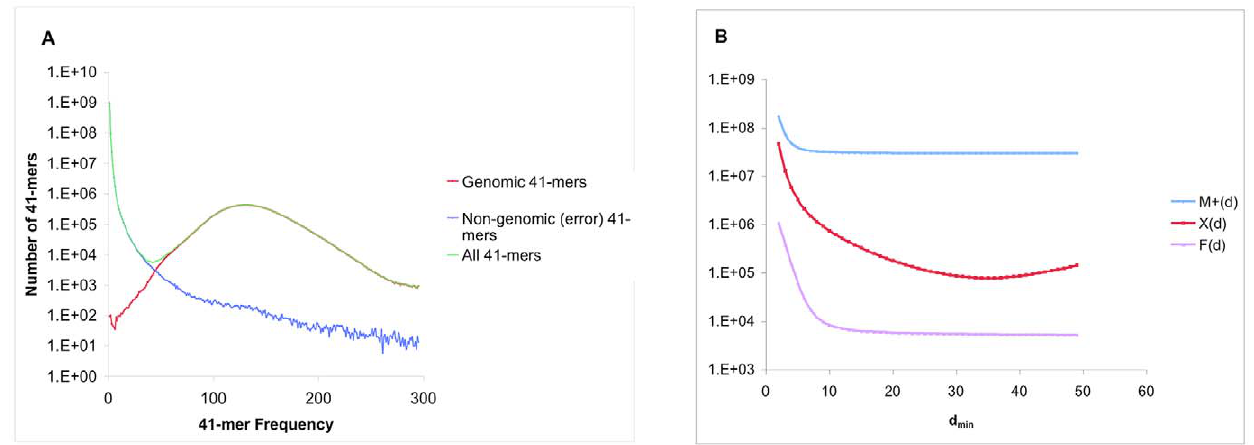
Figure 3. k-mer frequency and extension characteristics in Pichia . A. 41-mer frequency distributions . The overall 41-mer distribution (green) is decomposed into genomic (red) and non-genomic (yellow) contributions. At fewer than , 30 occurrences non-genomic (error-induced) 41- mers dominate. The modal frequency is , 135. B. Graph features as functions of d min . The total number of nodes (blue), total number of X- terminated nodes (red), and total number of F-terminated (yellow) nodes in the 41-mer graph are calculated as functions of the assembly parameter d min . We find the optimal assembly to occur at d min =10.